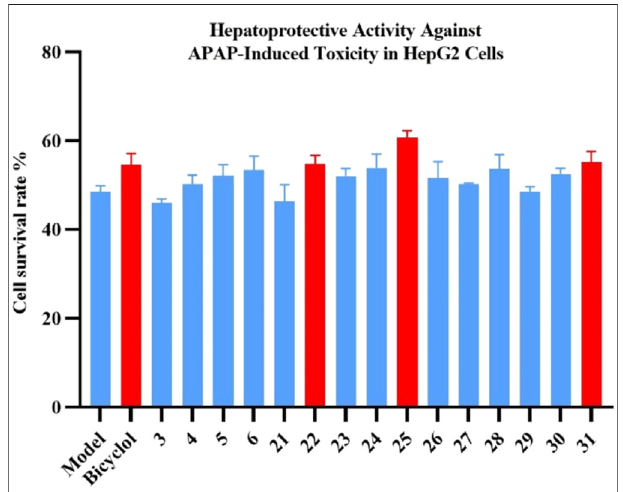
FIGURE 6 | Effects of compounds 3 – 6 and 21 – 31 on N -acteyl- p -aminophenol (APAP) – induced toxicity in HepG2 cells. Data are presented as the mean ± SD ( n = 3). Bicyclol was used as the positive